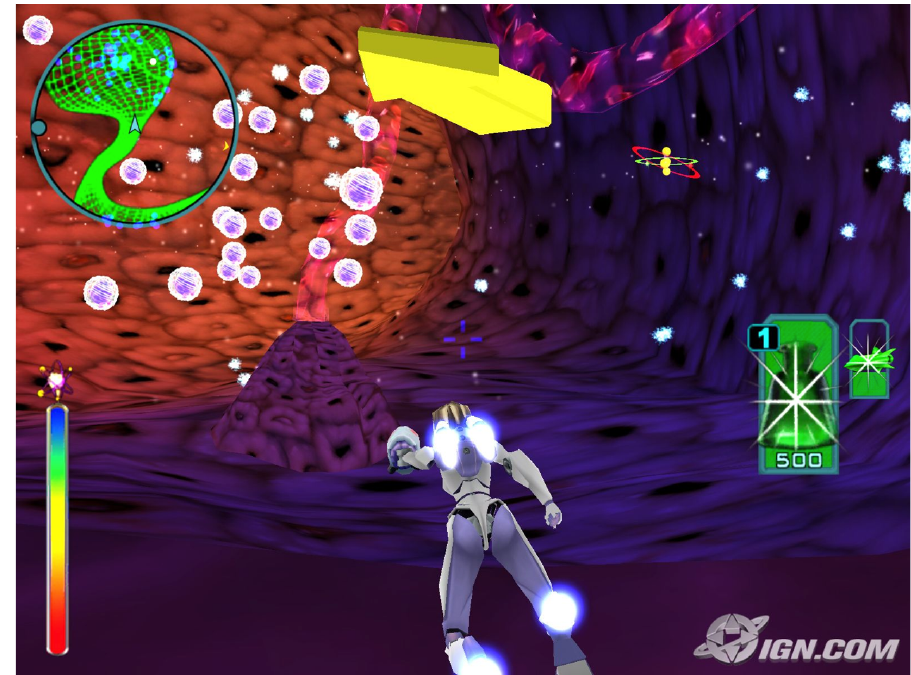
Figure 1. Screenshot of Re-Mission